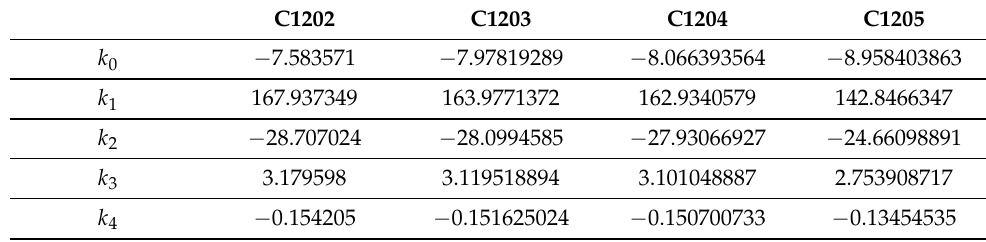
Table 3. Obtained OCV-SOC